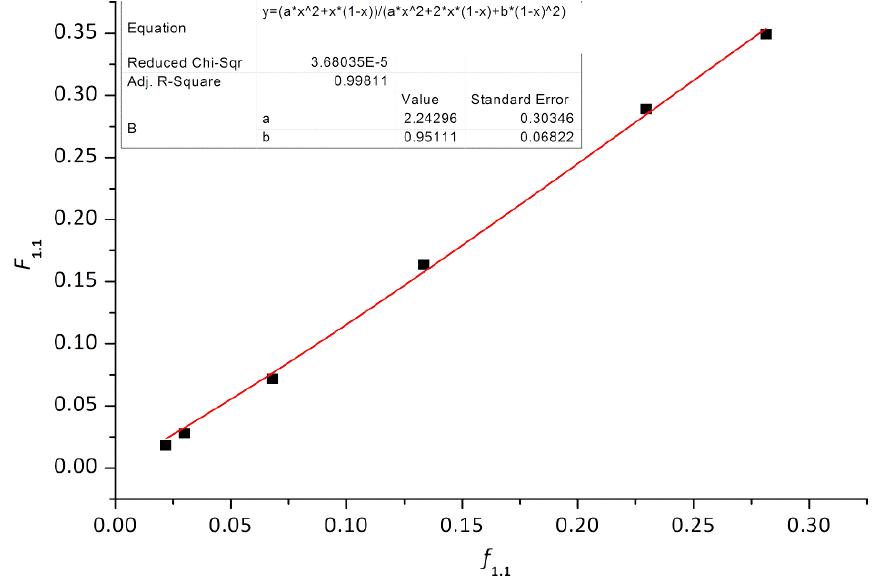
Figure 16. Copolymerization plot for a set of copolymerizations with BA and 1.1